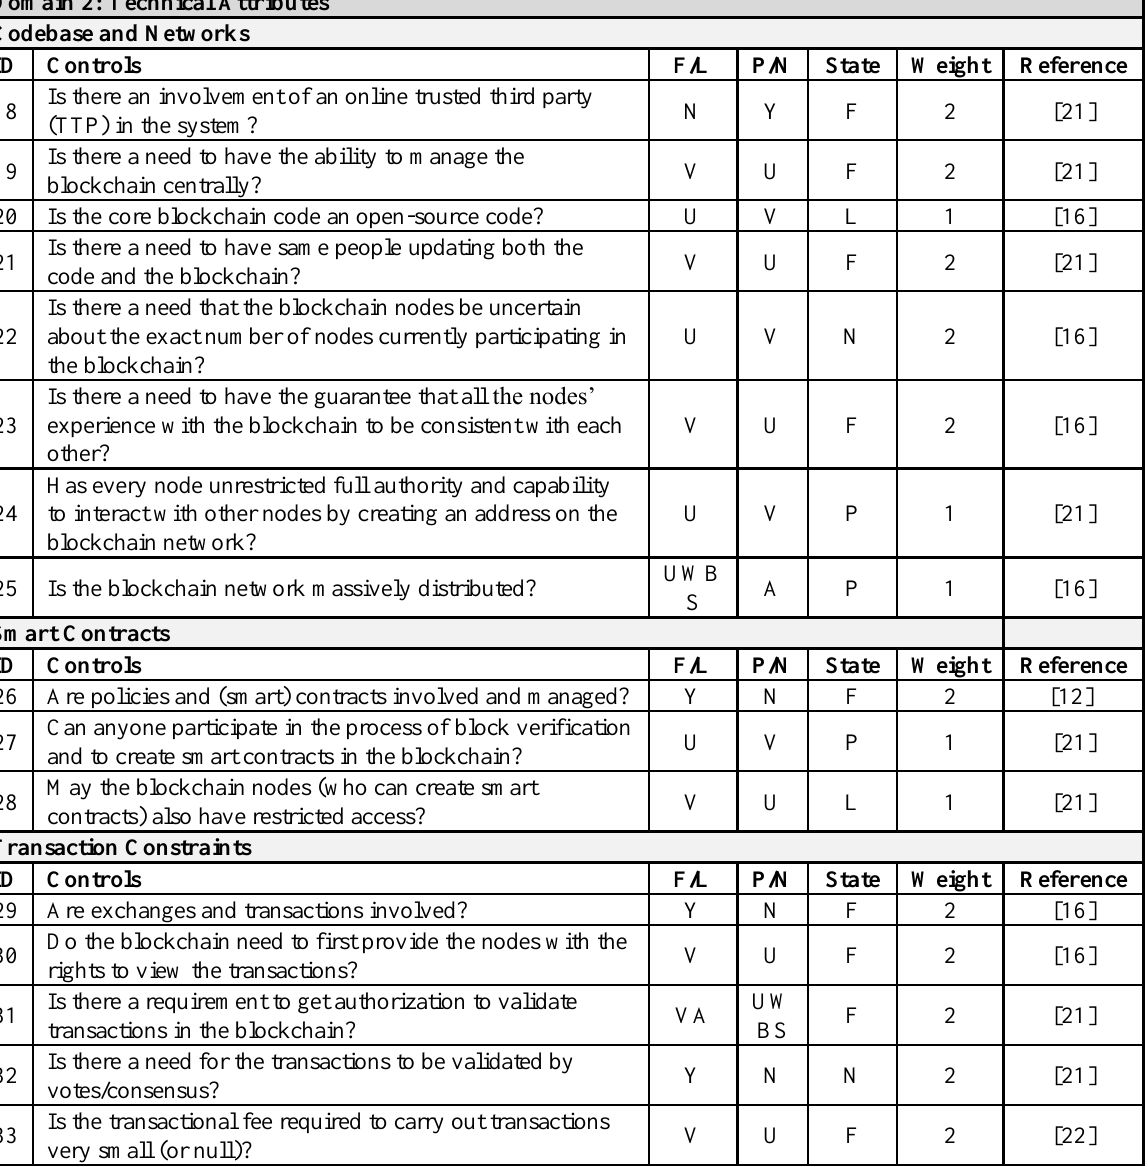
Table 3. Domain 2 of the blockchain applicability framework